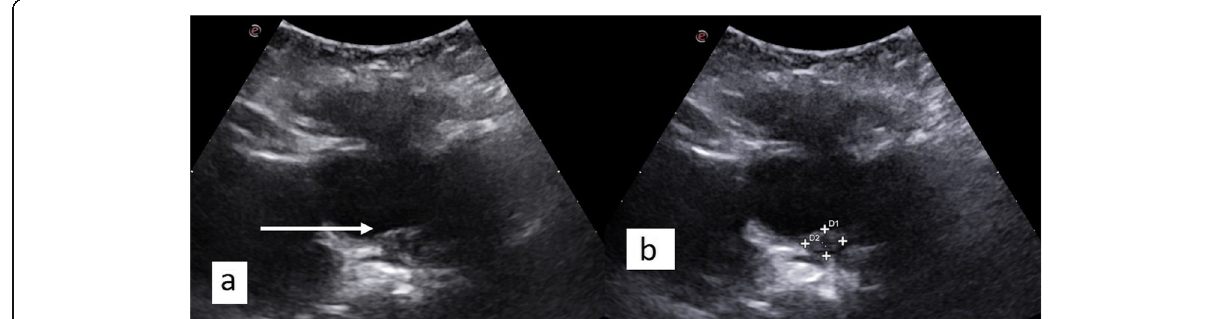
Fig. 3 Follow-up ultrasound after 6 weeks. Transverse grayscale ultrasound through the level of the pelvis shows a significant reduction in the size of the mass (arrow in a